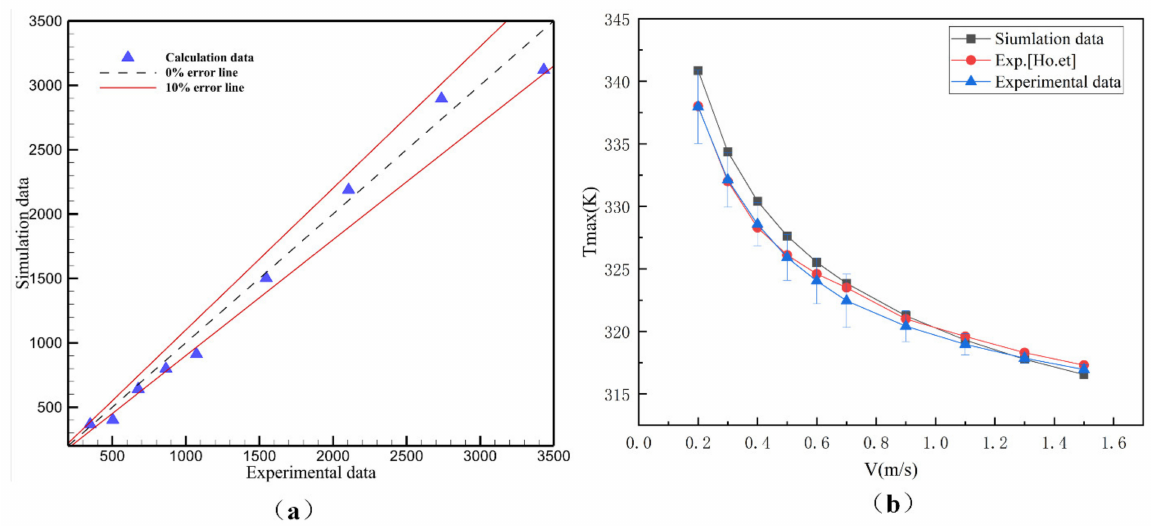
Figure 4. ( a ) Comparison diagram of experiment and simulation of pressure drop; ( b ) comparison diagram of bottom maximum temperature experiment and simulation.